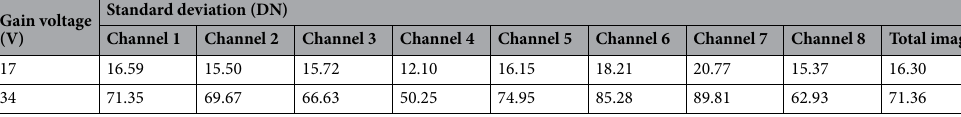
Table 3. Standard deviation of original 8-channel image.